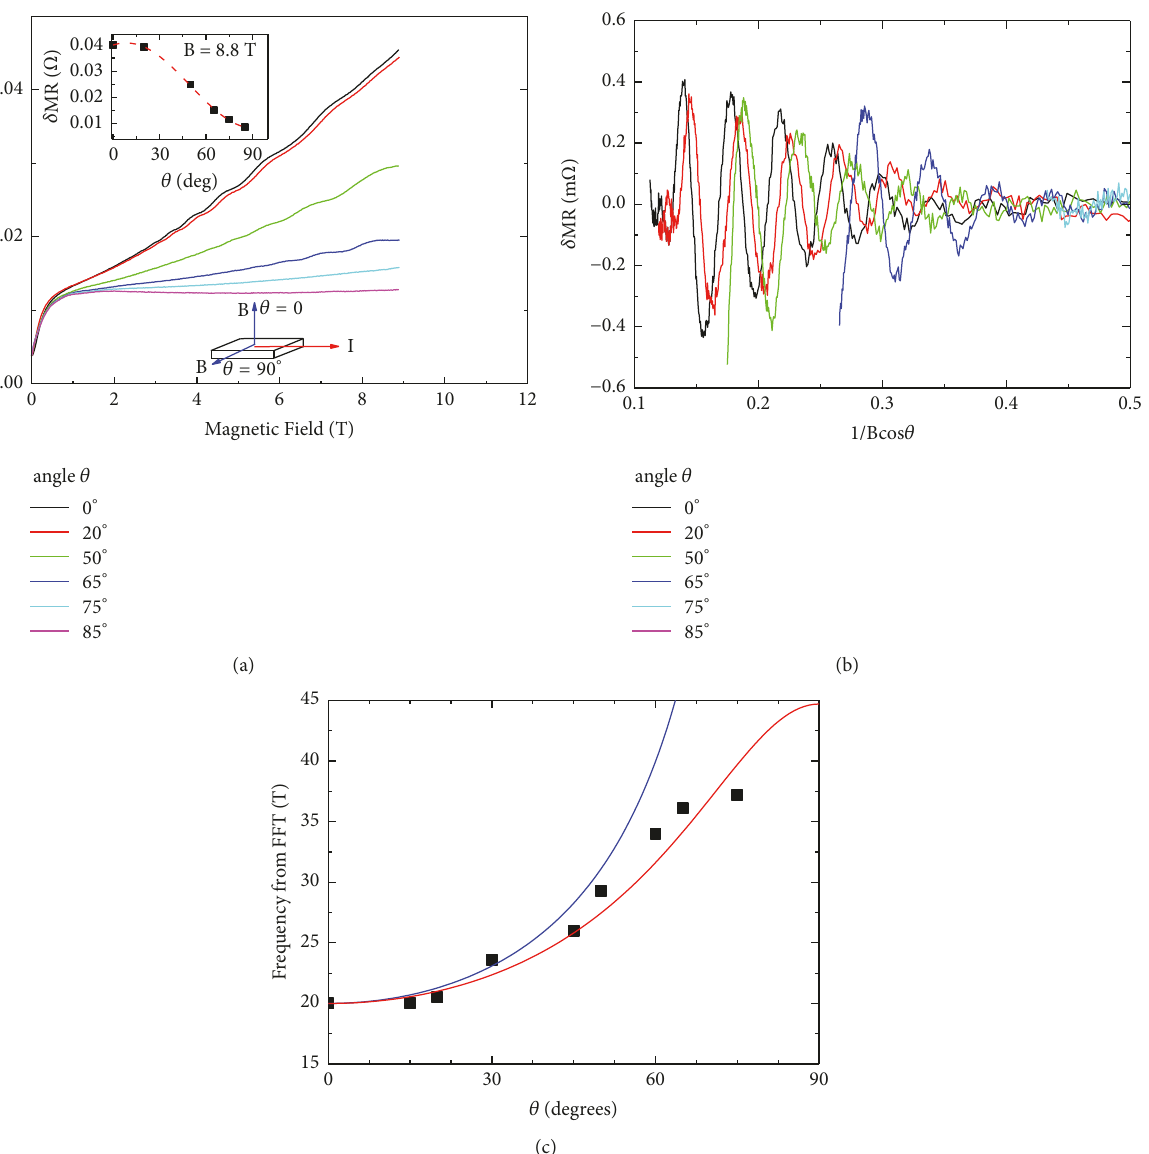
Figure 4: (a) Magnetoresistance at different angles, where 𝜃 is the angle between the magnetic field and the sample surface. The data are taken at T =2 K. Inset: variation of the MR in a magnetic field of 8.8 T. (b) SdH oscillations at various angles plotted against 1/( 𝐵 cos 𝜃 ). (c) Angular variation of the SdH frequencies obtained by FFT. Symbols: data points; blue line: expected behavior for a cylindrical Fermi surface; red line: comparison with a spheroidal Fermi